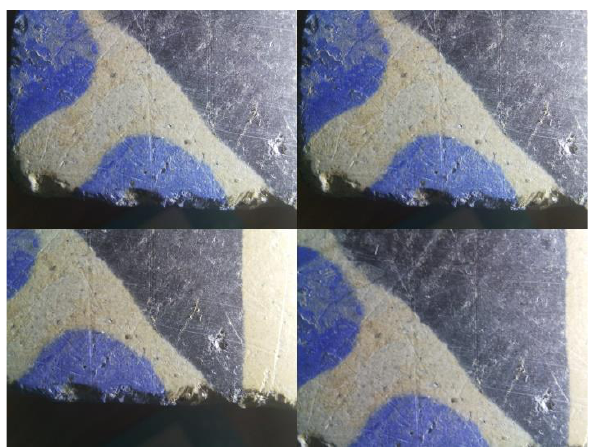
Figure 5 . Modernist hydraulic tiles dumped in a central street of Barcelona during an apartment refurbishment.